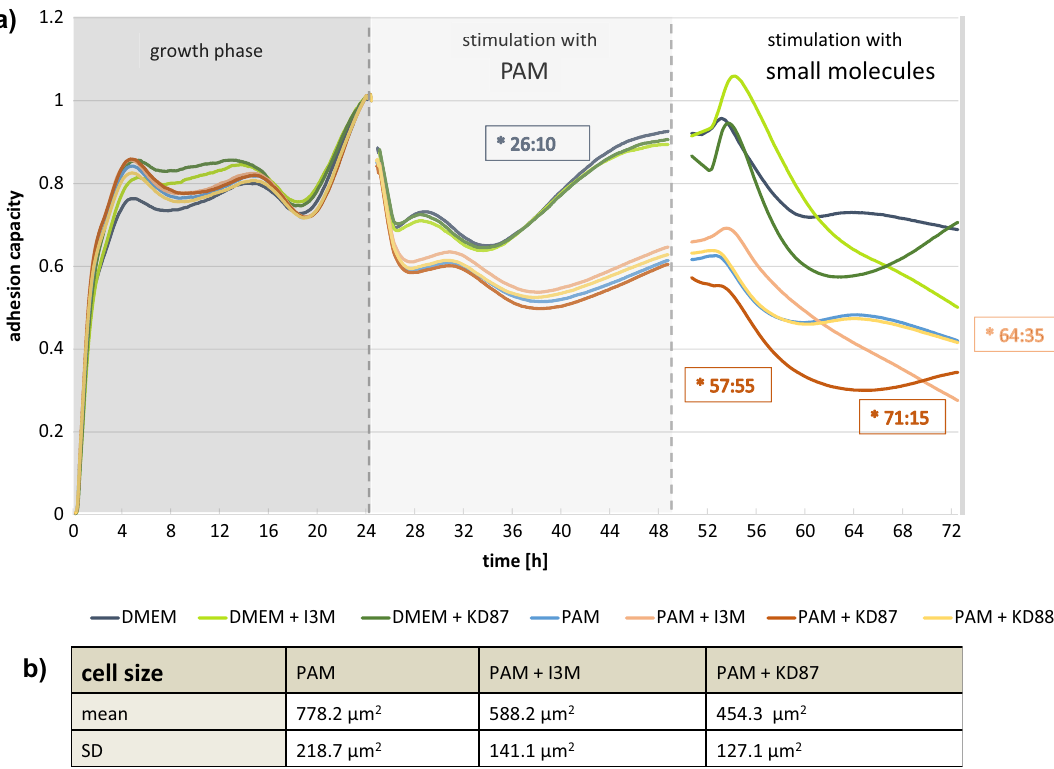
Figure 4. Influence of PAM and small molecules on the time course of A375 cell adhesion based on the impedance measurement. ( a ) Growth phase t0–t24, PAM t24–t48 and subsequent substance incubation t48– t72. The strong decrease in all curves at t24 can be attributed to the change to FCS-free medium (DMEM). The plasma treatment caused a significant decrease in adhesion (from time point 26:10) compared with DMEM (dark blue line). The subsequent stimulation with I3M and KD87 further lowered the adhesion capacity. The time points marked on the right (hh:mm) delimit the area of the adhesion curves that deviates significantly from the DMEM control. (Concentration of all indirubin derivatives was 10 µM; n = 4, mean values normalised to the last value before stimulation with PAM, left dashed line). ( b ) The cell size analysed from the microscopic images (see Fig. S1) after additional small molecule treatment was significantly reduced in comparison to PAM, confirming the reduced adhesion capacity (n = 25